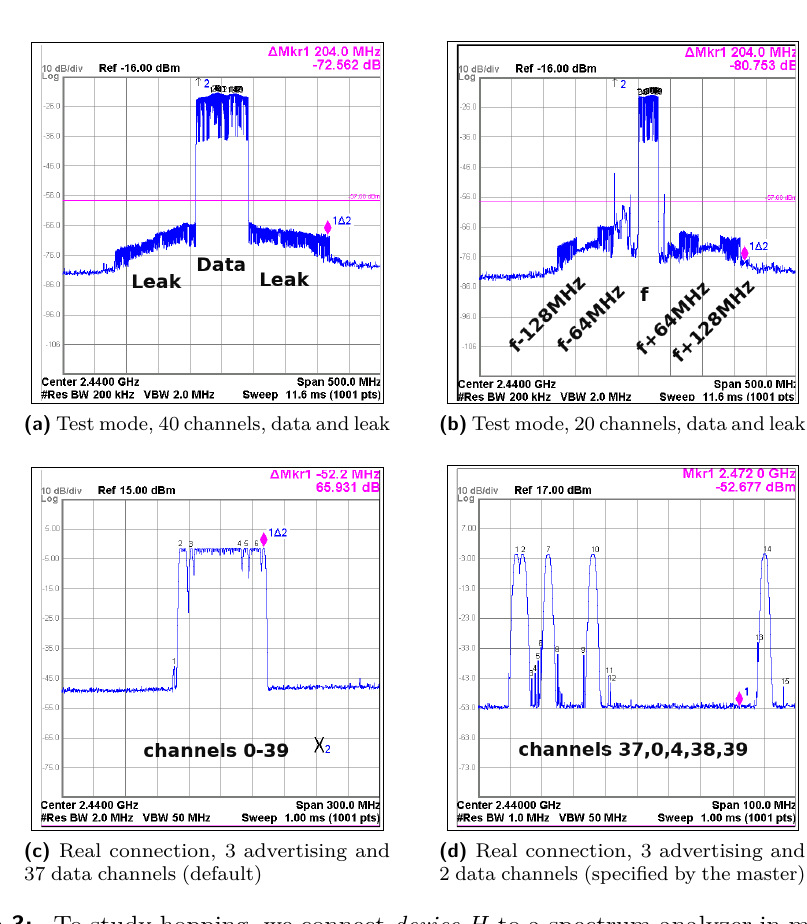
Figure 3: To study hopping, we connect device H to a spectrum analyzer in maximum hold mode. Each time a packet is sent on a channel a spike appears at the corresponding frequency. In test mode we configure the device to sweep over the BLE channels, data and the leak at the multiples of the clock are clearly visible (a)(b). In a real connection, the device uses all the 40 channels by default (c). We can reduce the channels used by a real connection to 5 by blacklisting the others from the master side